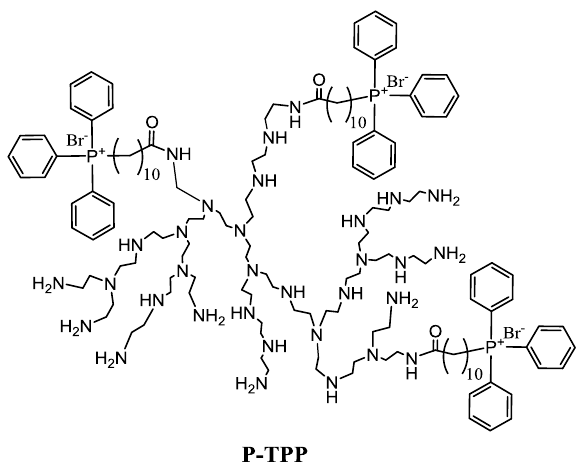
Scheme 1 . Schematic representation of